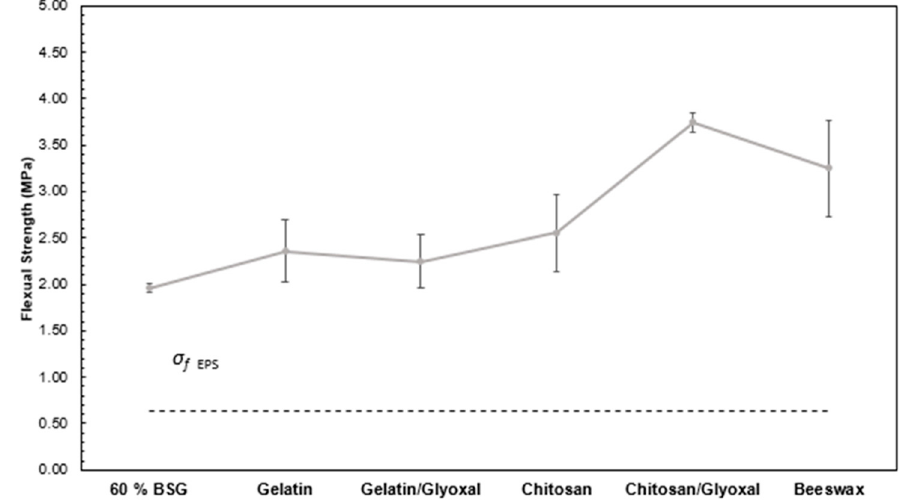
Figure 11. Flexural strength of trays with 60% of BSG and different additives (gelatin, gelatin and glyoxal, chitosan, chitosan and glyoxal and beeswax).